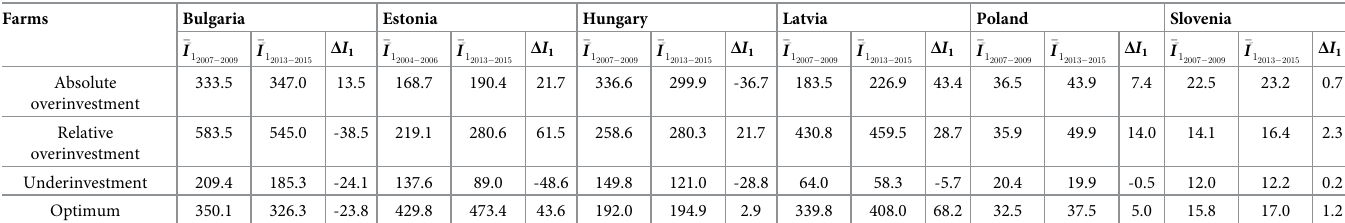
Table 2. Land resources (ha per farm) in farms grouped by scale of investment in 2007–2009 and 2013–2015 ( I 8 ). Farms Bulgaria Absolute overinvestment Relative overinvestment